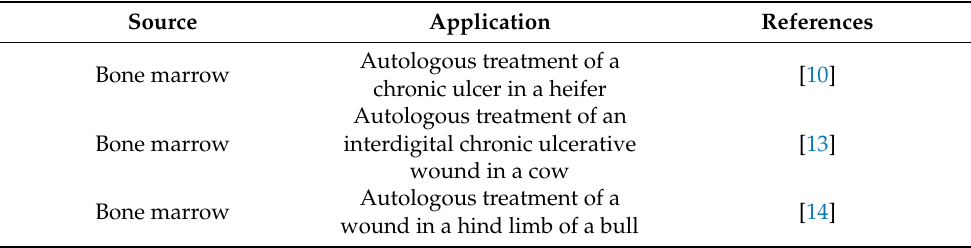
Table 1. Bovine MSC applications for wound healing.